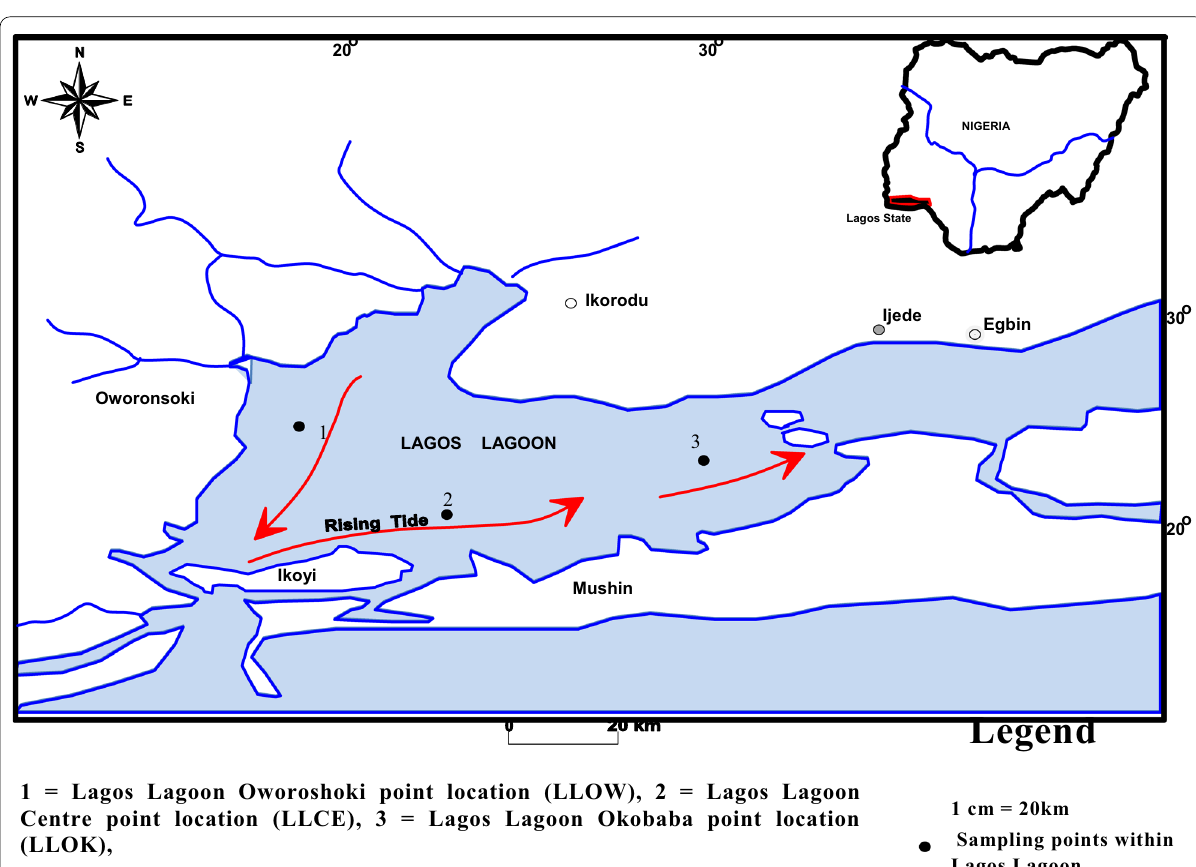
Fig. 2 Map of Lagos